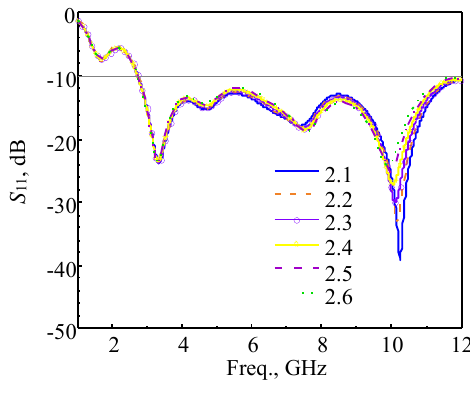
Fig. 3. Measured and simulated S 11